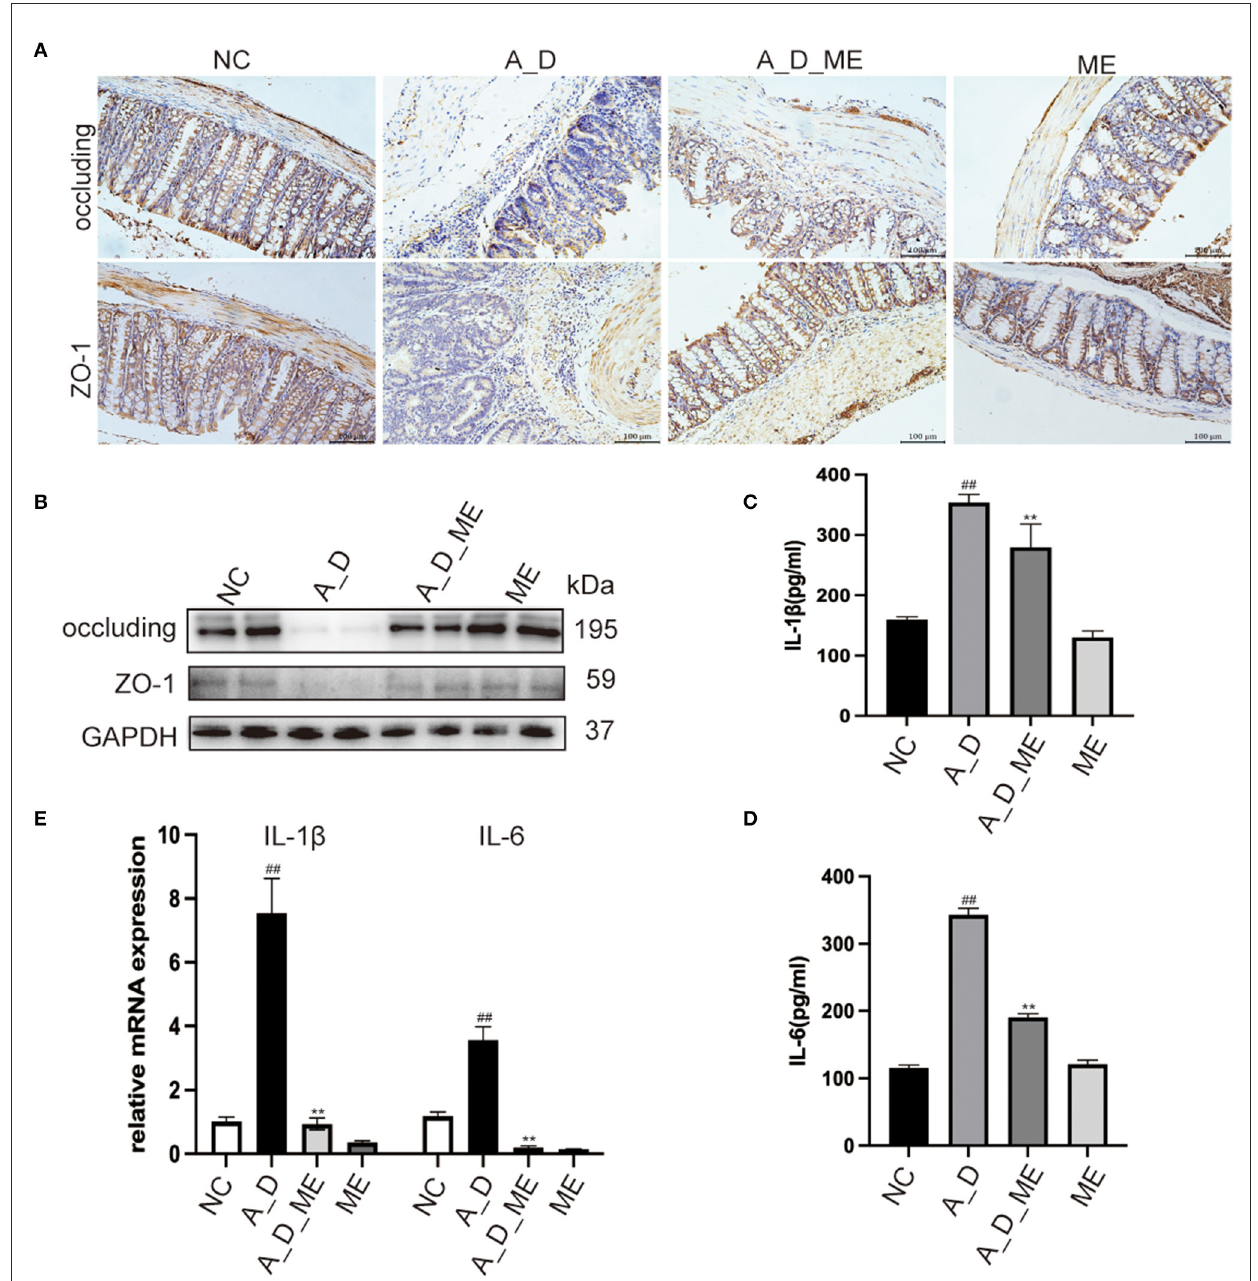
FIGURE3 Effects of ME on the regulation of tight junction proteins and inflammatory responses in AOM/DSS-treated mice. (A) representative IHC staining of occluding and ZO-1 in treated mice as expressed. Scale bar = 100m. (B) the expression of occluding and ZO-1 in colon tissues was detected by Western blotting. Graphs were quantified using GAPDH as the internal reference. (C, D) the serum levels of IL-1 β as well as IL-6 in four groups. (E) the relative mRNA levels of IL-1 β as well as IL-6 in the colon tissues. Data represent the mean ± SD, ## p < 0.01 compared to normal control, ** p < 0.01 compared with the model group. N =